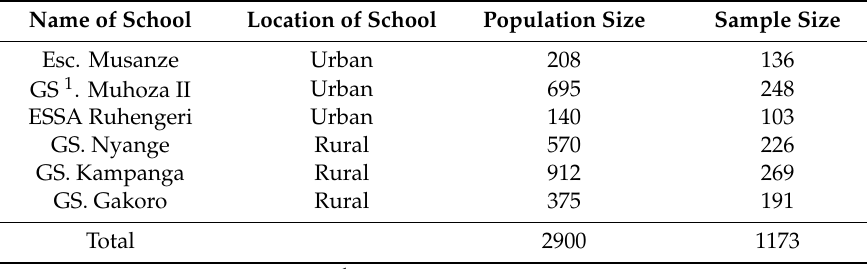
Table 1. Schools’ population and sample size.